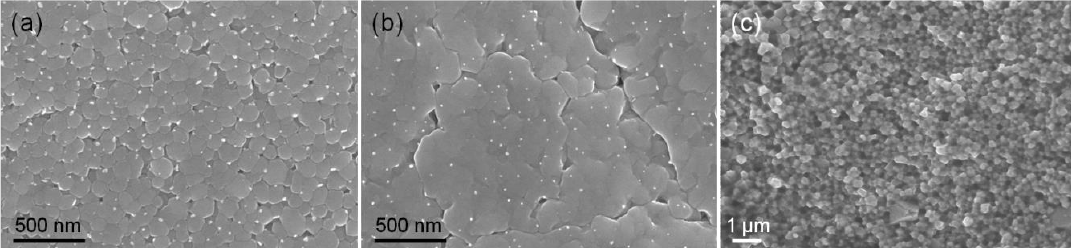
Figure 1. Scanning Electron Microscopy ( SEM) images of Hf 0.35 Zr 0.35 7Ti 0.3 NiSn 0.99 Sb 0.01 . ( a ) Contact surface of melt spun ribbon. ( b ) Free surface of melt spun ribbon. ( c ) Fractured surface of SPSed bulk.